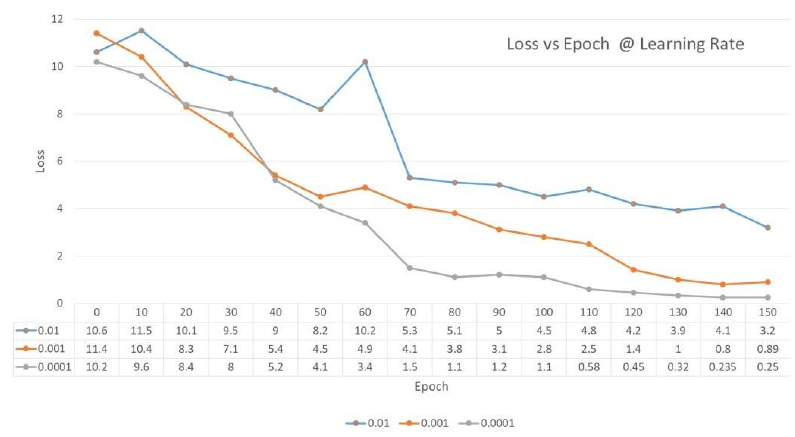
Figure 13. Comparison of Loss vs Epoch @ Learning Rate.